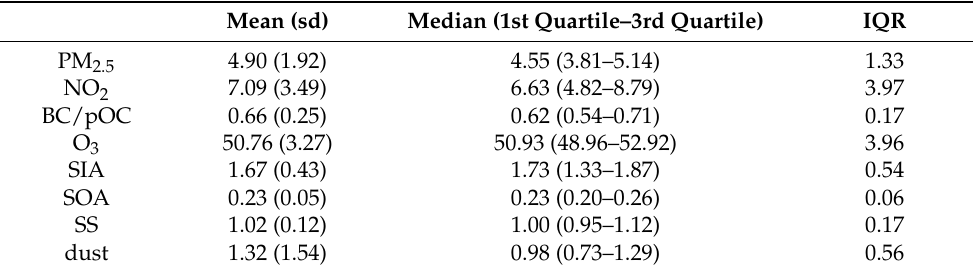
Table 2. Air pollution concentrations for the years of follow-up presented as means and standard deviations together with quartile limits and inter-quartile ranges